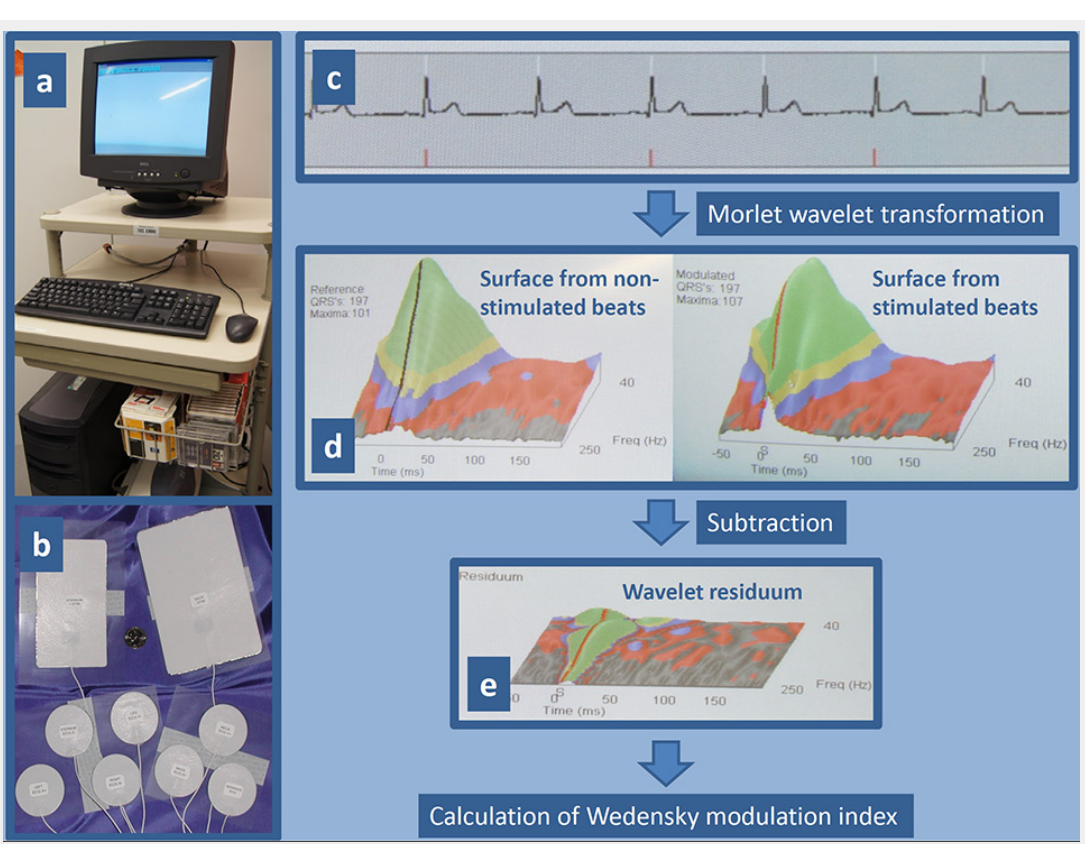
The device for Wedensky modulation consists of a standard computer system equipped with an adapter for the special electrodes and software for analysis of the ECG signal (a). The set of electrodes includes two large-size electrodes for the application of sub-threshold stimuli, which are placed on the sternum and back, and seven small-size electrodes for the recording of a high resolution ECG (b). Example of an ECG recording (c): the white tick marks show where the software detected an R-wave, and the red tick marks show when a sub-threshold stimulus was delivered. ECG recordings are analysed using three-dimensional Morlet wavelet transformation separately for stimulated and non-stimulated heart beats. The wavelet transformation averages the vector magnitude of the beats, separates the frequency of the beats, and displays the results as a three-dimensional surface whose axes are time (x axis), frequency (y axis), and amplitude (z axis) (d). To reveal the difference between the stimulated and non-stimulated beats the surfaces are arithmetically subtracted resulting in a wavelet residuum (e). Any variation in the wavelet residuum plane represents a response caused by the stimulation. The key indicators of the wavelet residuum are mathematically combined to calculate the Wedensky modulation